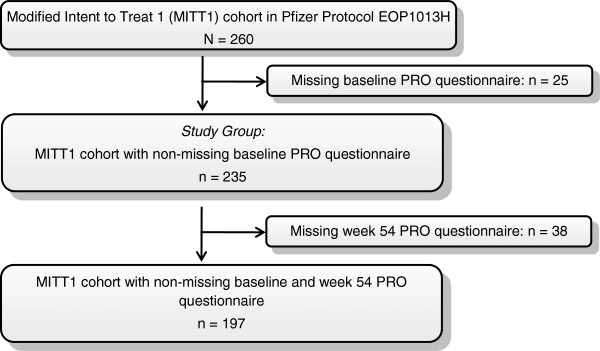
CONSORT diagram.